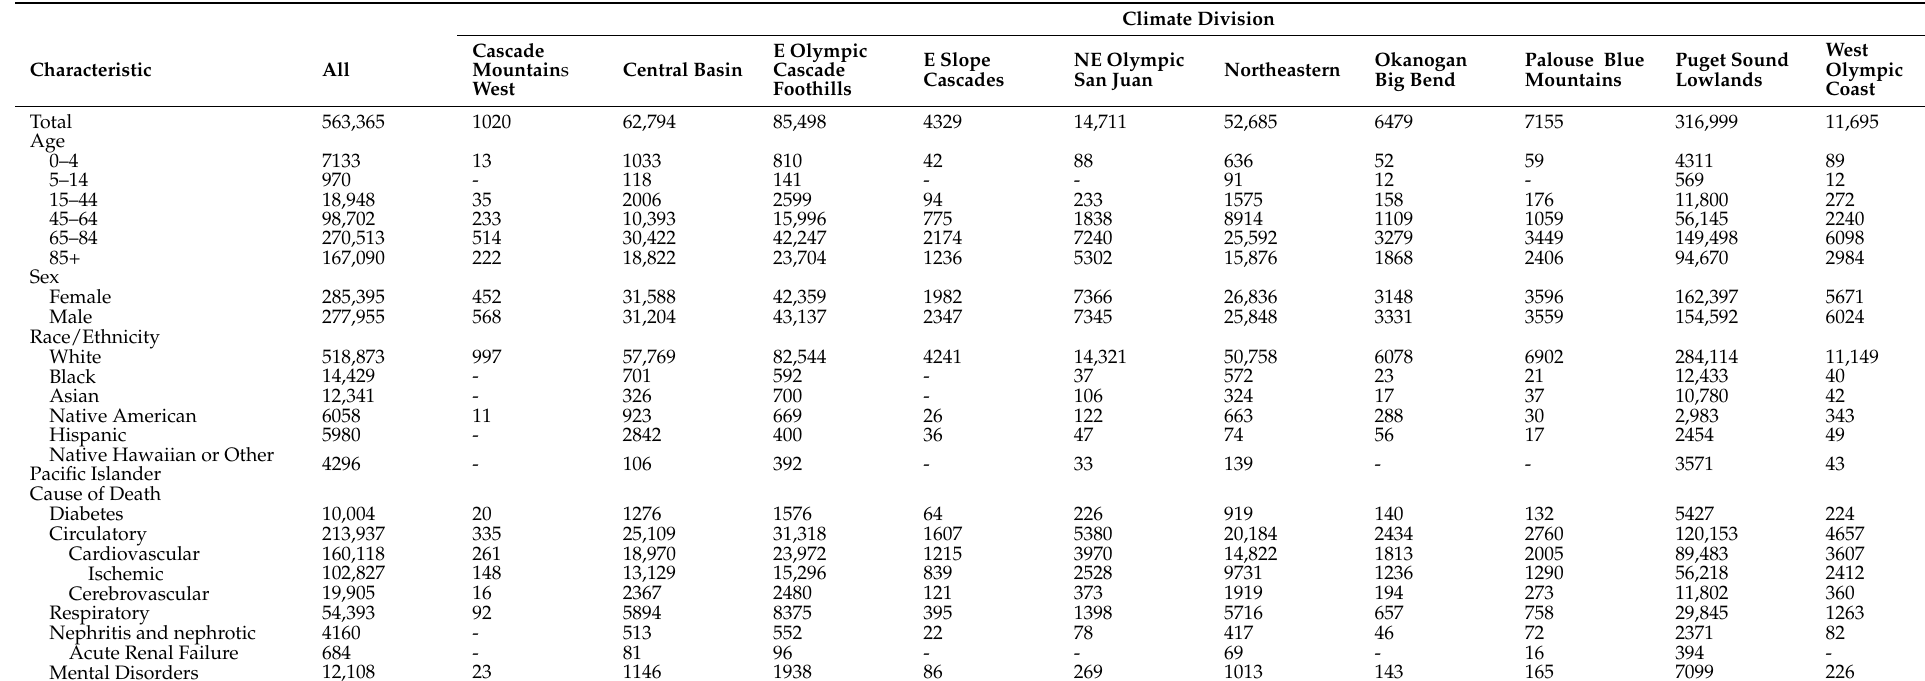
Table 1. Non-traumatic mortality